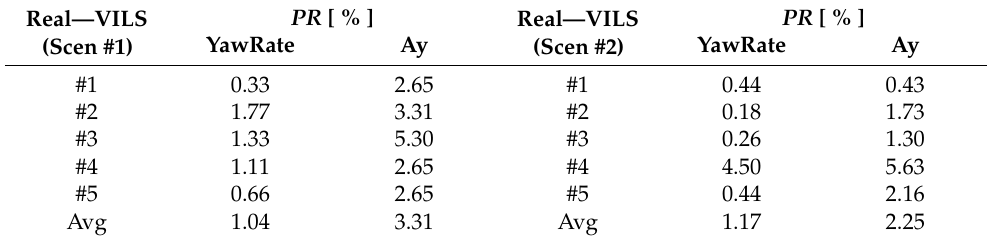
Table 7. Data comparison result—Yaw rate, Lateral acceleration